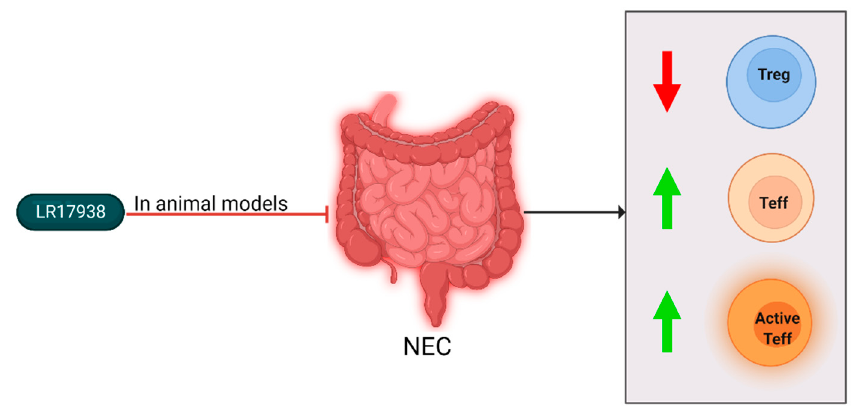
Figure 5. Cellular changes observed in NEC patients and experimental animal models and the effect of LR17938 supplementation. After NEC diagnosis or induction, Treg levels decreased (downward arrow), and Teff levels and activation increased (upward arrow). In mouse and rat models,